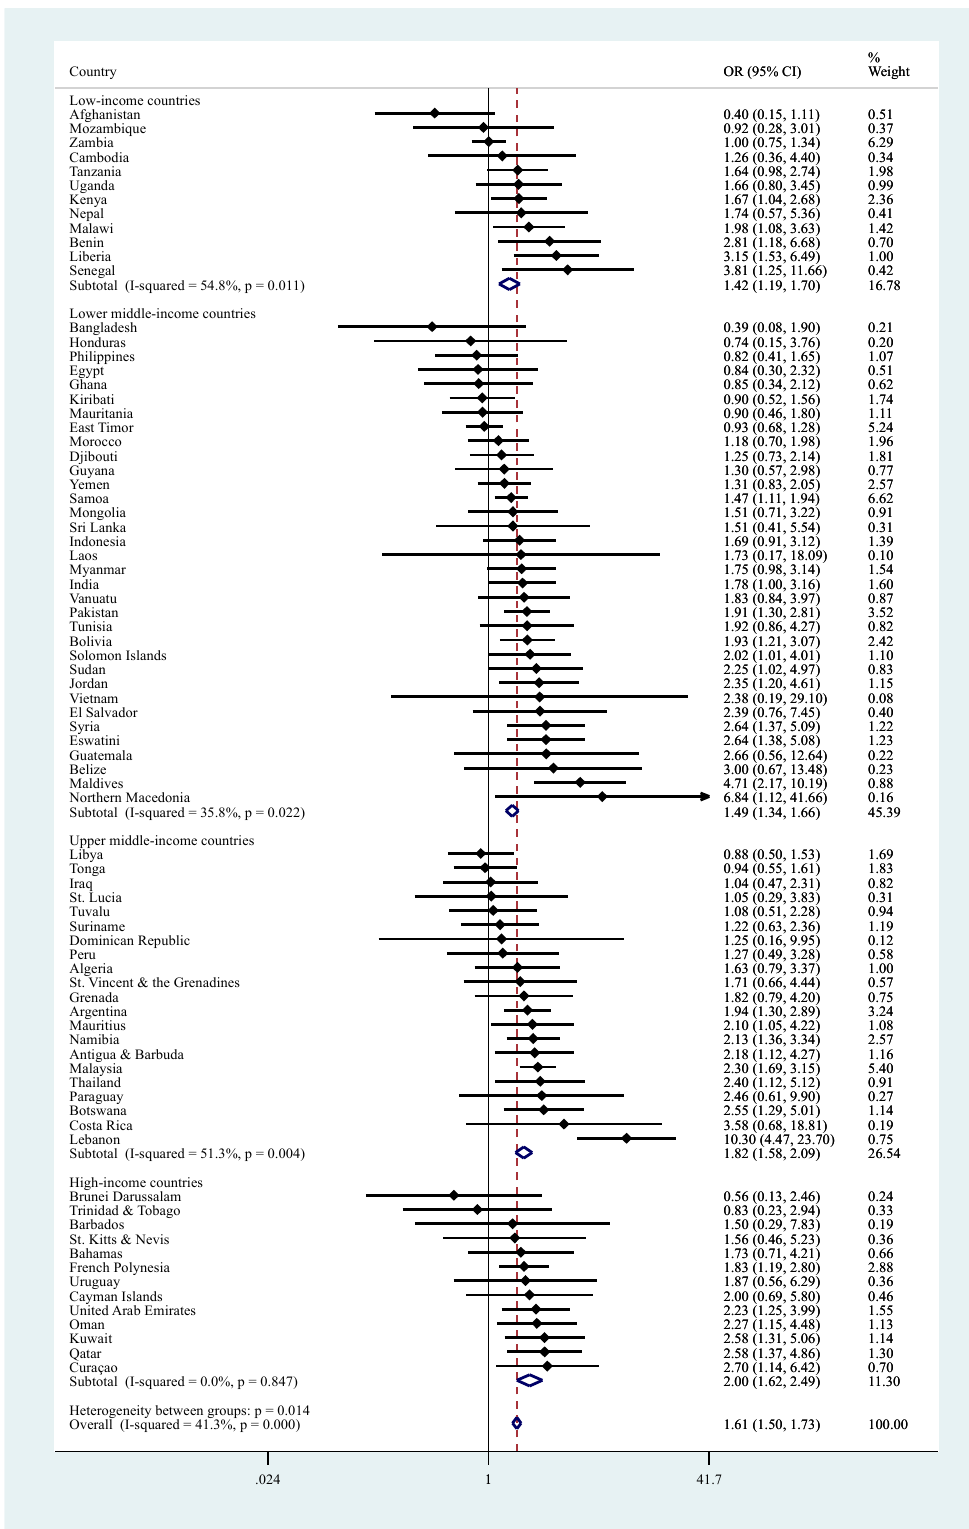
Heterogeneity between groups: p = 0.014 Overall (I-squared = 41.3%, p = 0.000)